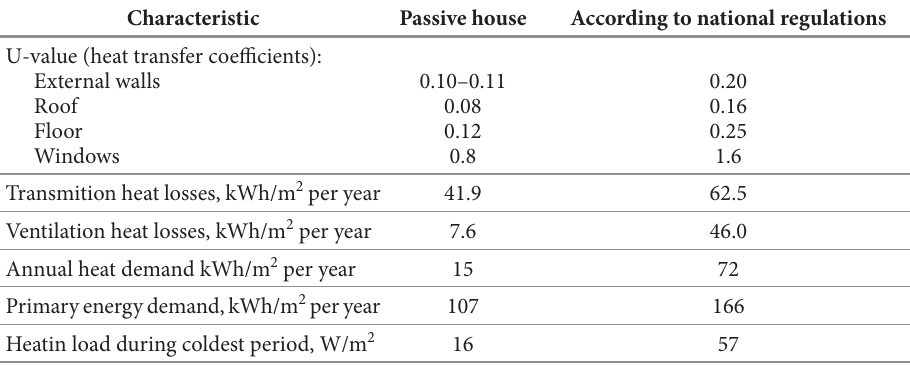
Table 1. Technical and economical characteristics of the building Characteristic Passive house According to national regulations